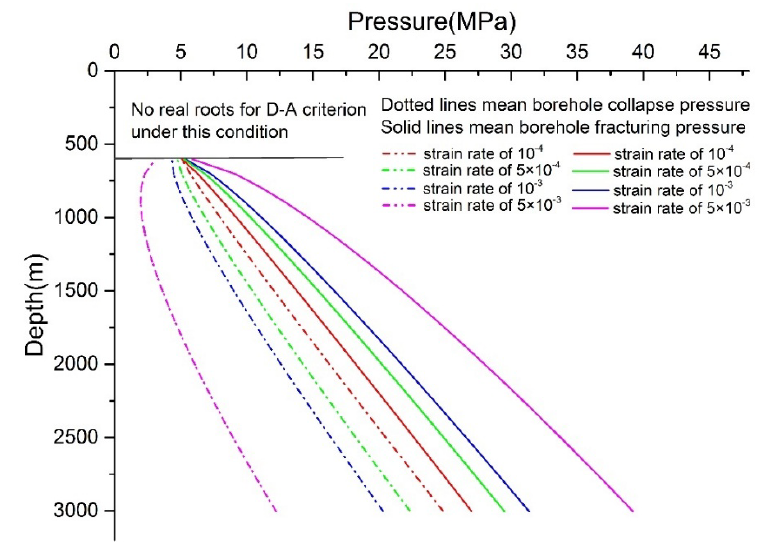
Figure 8. Critical borehole fracturing and collapse pressure changes at different strain rates calculated by the Derradji-Aouat criterion.